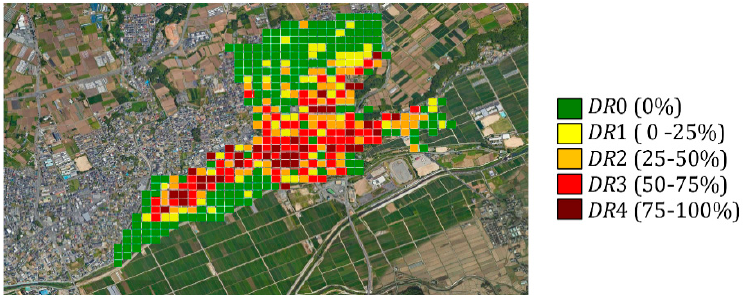
Figure 12. The grid-based major damage rate (DR) by the field survey [33]. Five DR categories indicate the number of buildings belongs to major damage categories (damage levels 4 and 5 [34]) among the total number of buildings in each grid cell.